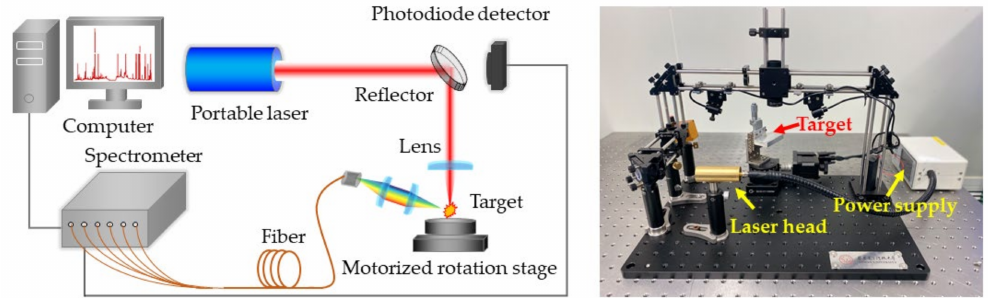
Figure 1. Schematic and picture of the LIBS experimental